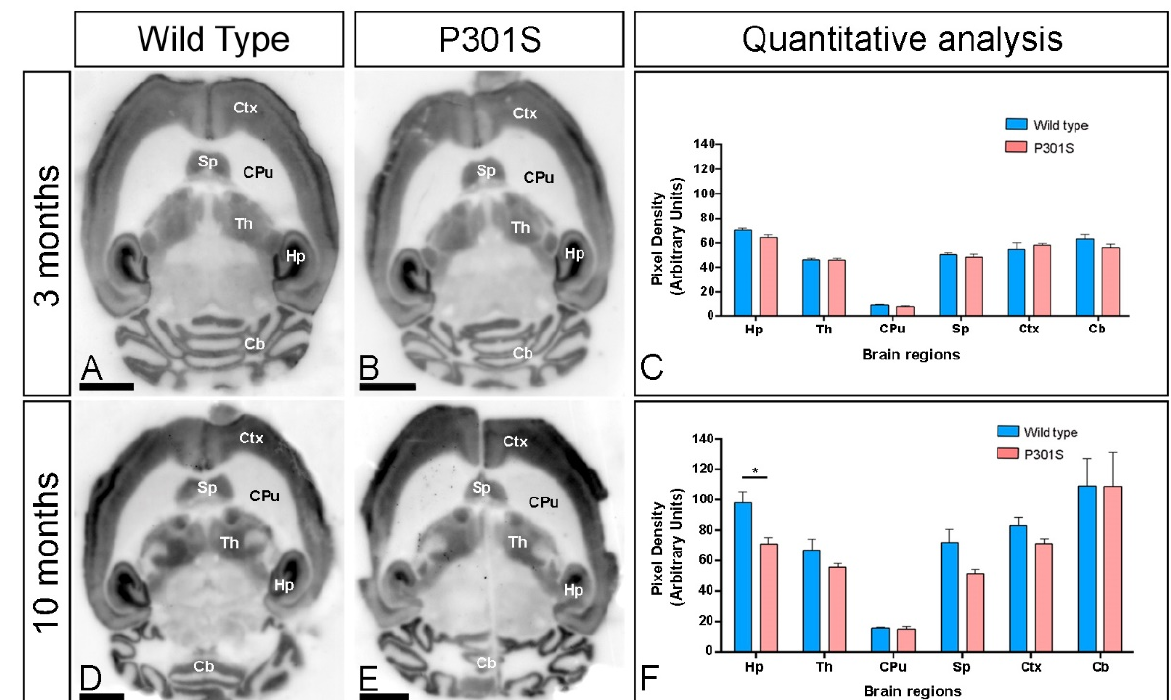
Figure 1. Regional expression of GIRK2 in the brain of P301S mice. ( A – F ) The expression of the GIRK2 protein was visualised in histoblots of horizontal brain sections at 3 and 10 months of age in wild type and P301S mice using an affinity ‐ purified anti ‐ GIRK2 antibody. GIRK2 exhibited broad distributions in the brain and region ‐ specific differences were determined by densitometric analysis of the scanned histoblots (panels C , F ). Strong GIRK2 staining was observed in the hippocampus (Hp), neocortex (Ctx), cerebellum (Cb), septum (Sp), and thalamus (Th), with moderate staining in midbrain nuclei and faint in the caudate putamen (CPu). Densitometric analysis showed no differences in GIRK2 expression in the brain of P301S mice at 3 months but showed a significant decrease in the hippocampus at 10 months of age (Multiple t ‐ tests and Holm ‐ Sidack method, * p < 0.05). Error bars indicate SEM. Scale bars: 0.2 cm.